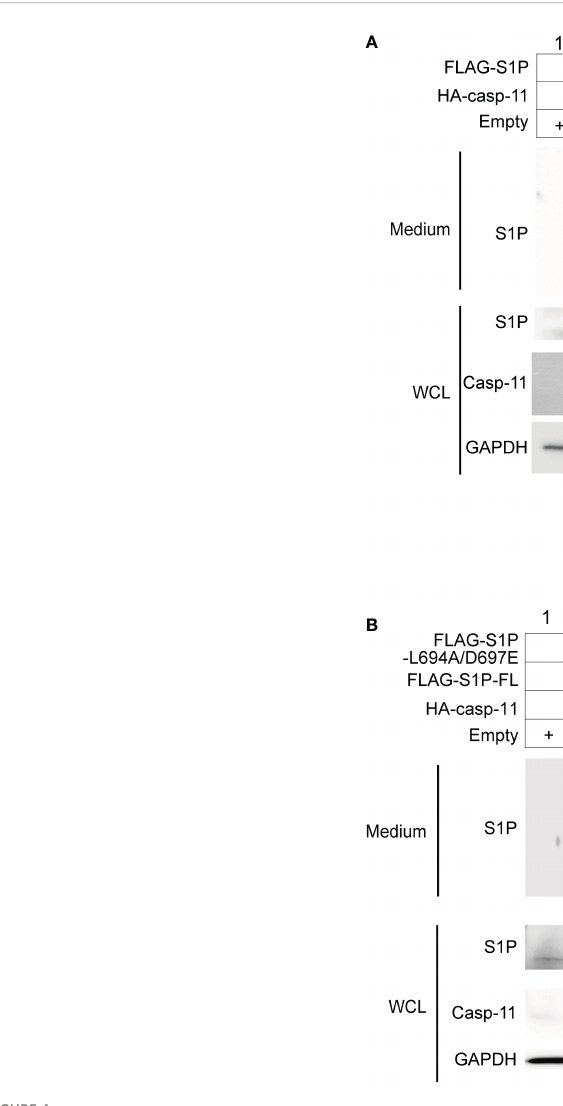
FIGURE 4 Caspase-11 is necessary for the formation of the secreted form of S1P. (A) HEK293T cells were transfected with plasmids containing FLAG-tagged full- length S1P and HA-tagged caspase-11. Twenty-four hours after transfection, WCLs and culture medium were collected, and the levels of the processed forms of S1P were assessed by western blotting using an anti-S1P antibody. (B) HEK293T cells were transfected with plasmids containing WT FLAG-S1P or a FLAG-S1P carrying mutations in the caspase-11-binding sequence (L694A/D697E). Twenty-four hours after transfection, culture medium and WCLs were collected and subjected to western blotting using anti-S1P and anti-caspase-11 antibodies. The arrowhead indicates the band corresponding to endogenous S1P. Asterisks indicate non-speci fi c